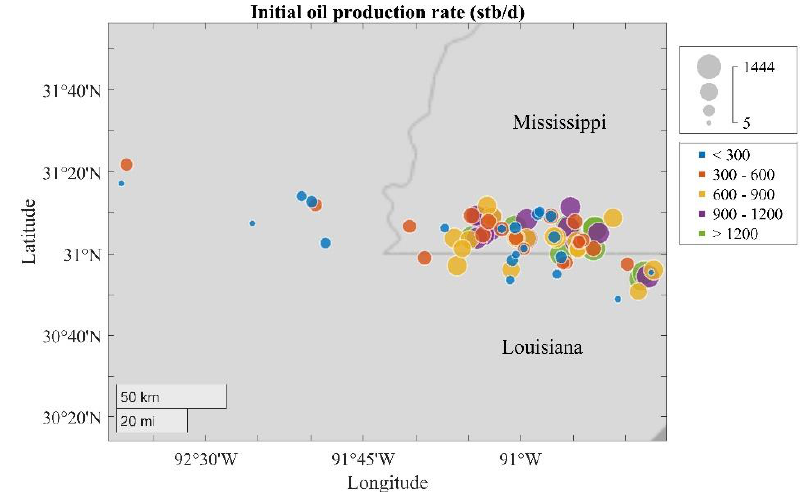
Figure 4. Bubble map of the initial well productivity of Tuscaloosa Marine Shale (TMS) wells.